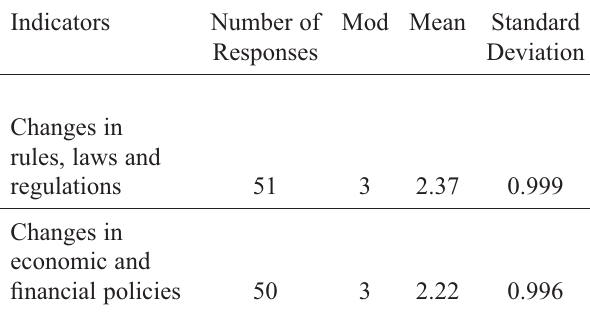
Table 12 . Changes in economic and fi nancial policies are (1:highly unpredictable; 5: highly predictable) Indicators